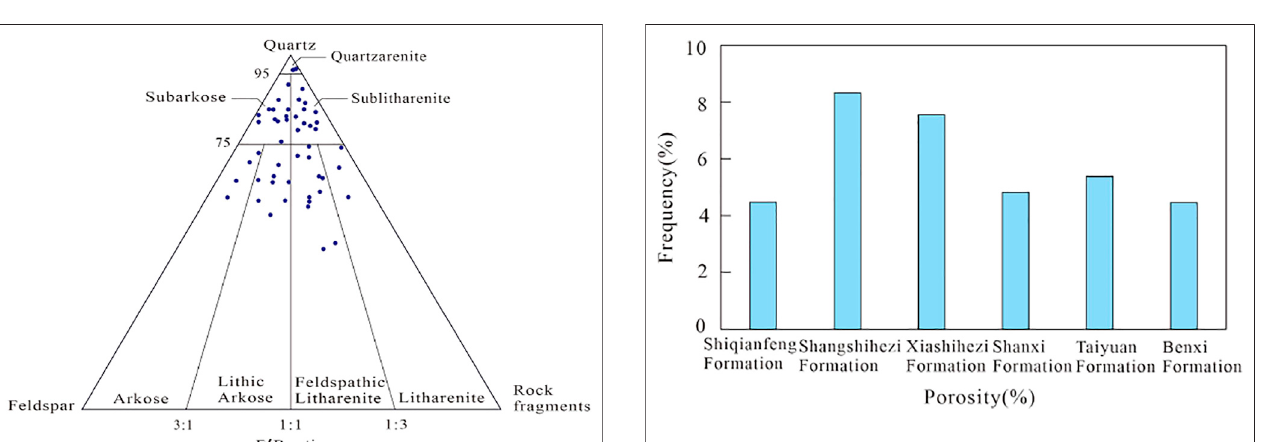
TABLE 1 | Statistical table of rock composition and structural characteristics of Upper Paleozoic sandstone in Dongpu Depression (Yang, 2018).